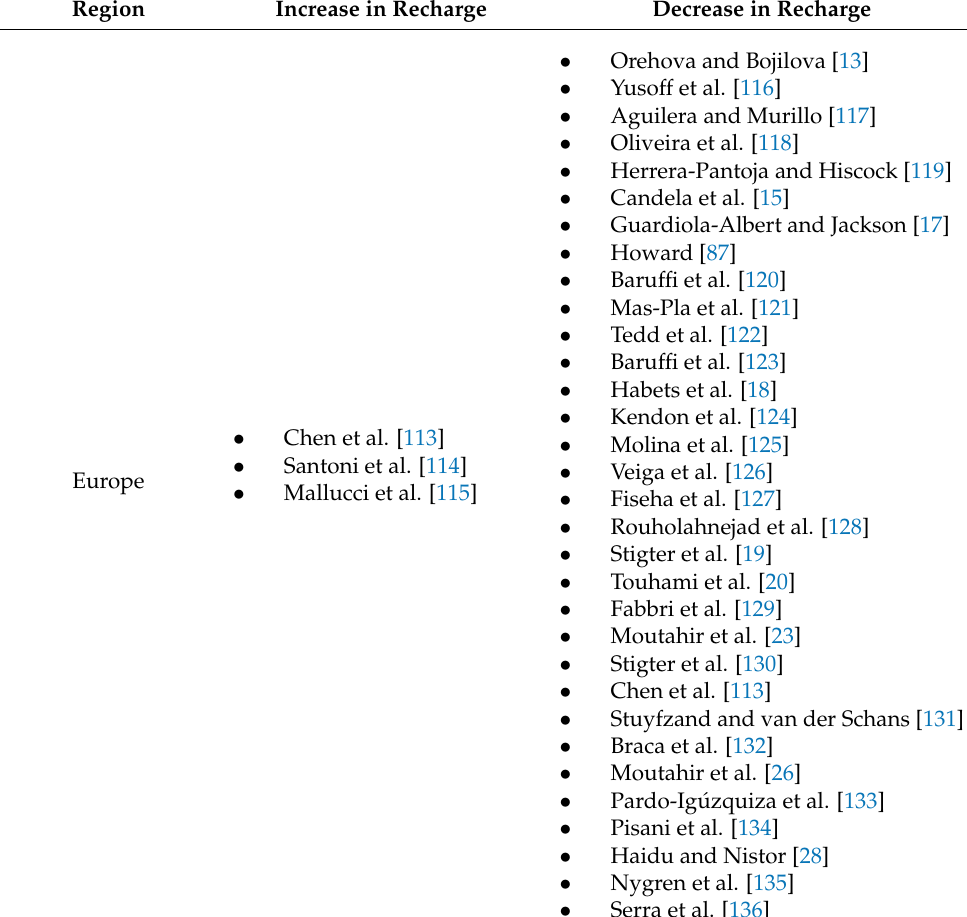
Table 6. Scientific production identified for Europe.